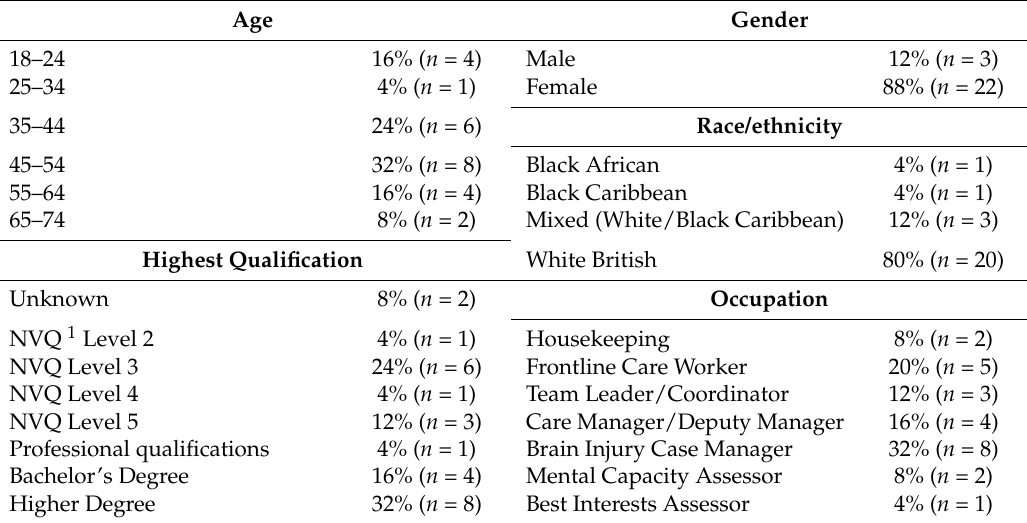
Table 2. Demographics: Social Care